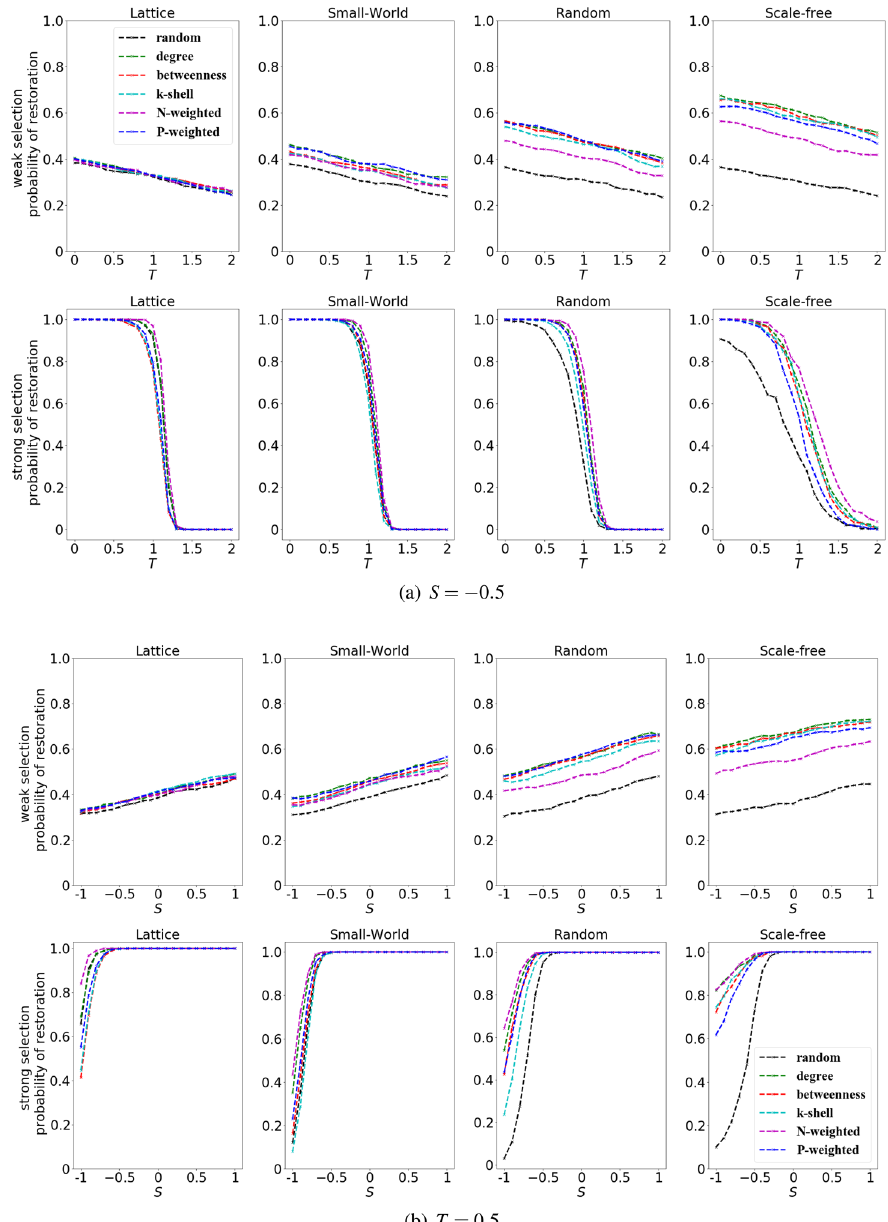
Figure 8. Random ranking works better in lattices than in scale-free networks. We show the probability of cooperation restoration for different networks and rankings. For a fixed S = − 0.5 , the values of T are varied between 0 and 2 (upper panel), and for a fixed T = 0.5 , the values of S are varied between − 1 and 1. The initial density of cooperators is ρ = 30% , and the probability of cooperation restoration is computed at weak ( w = 0.001 ) and strong selection( w = 0.1